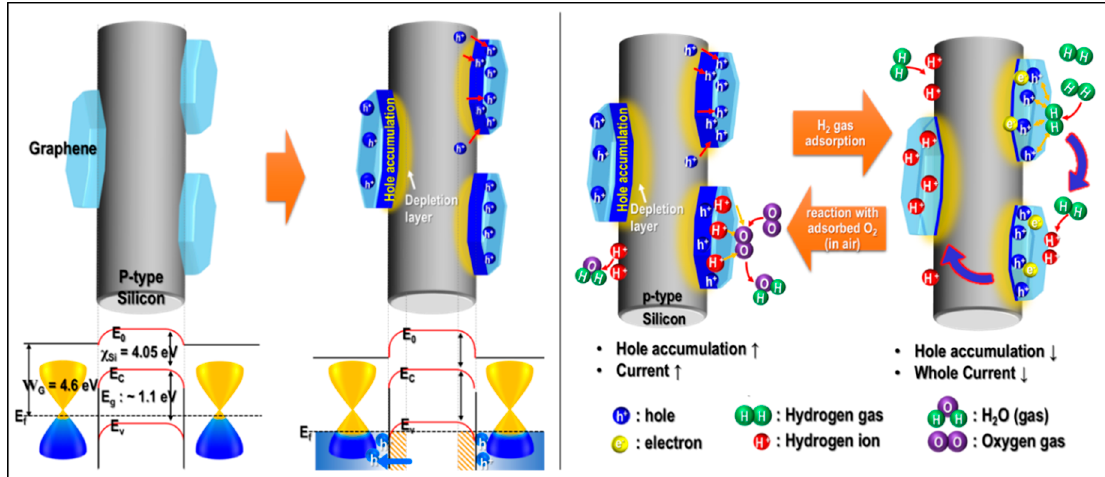
Figure 4. Schematic illustration showing the adsorption and desorption mechanism of H 2 gas on the surface of doped-graphene on a p-Si wafer.